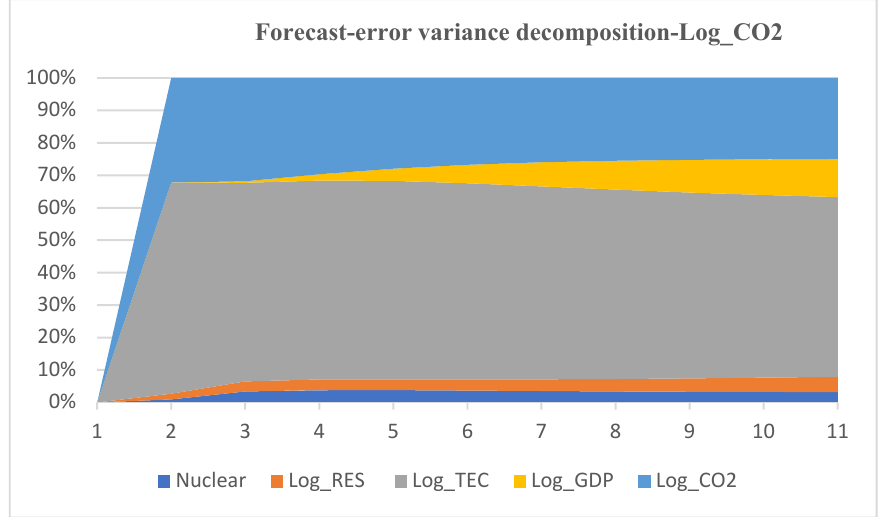
Figure 5. Forecast error variance decomposition Log_CO 2 .